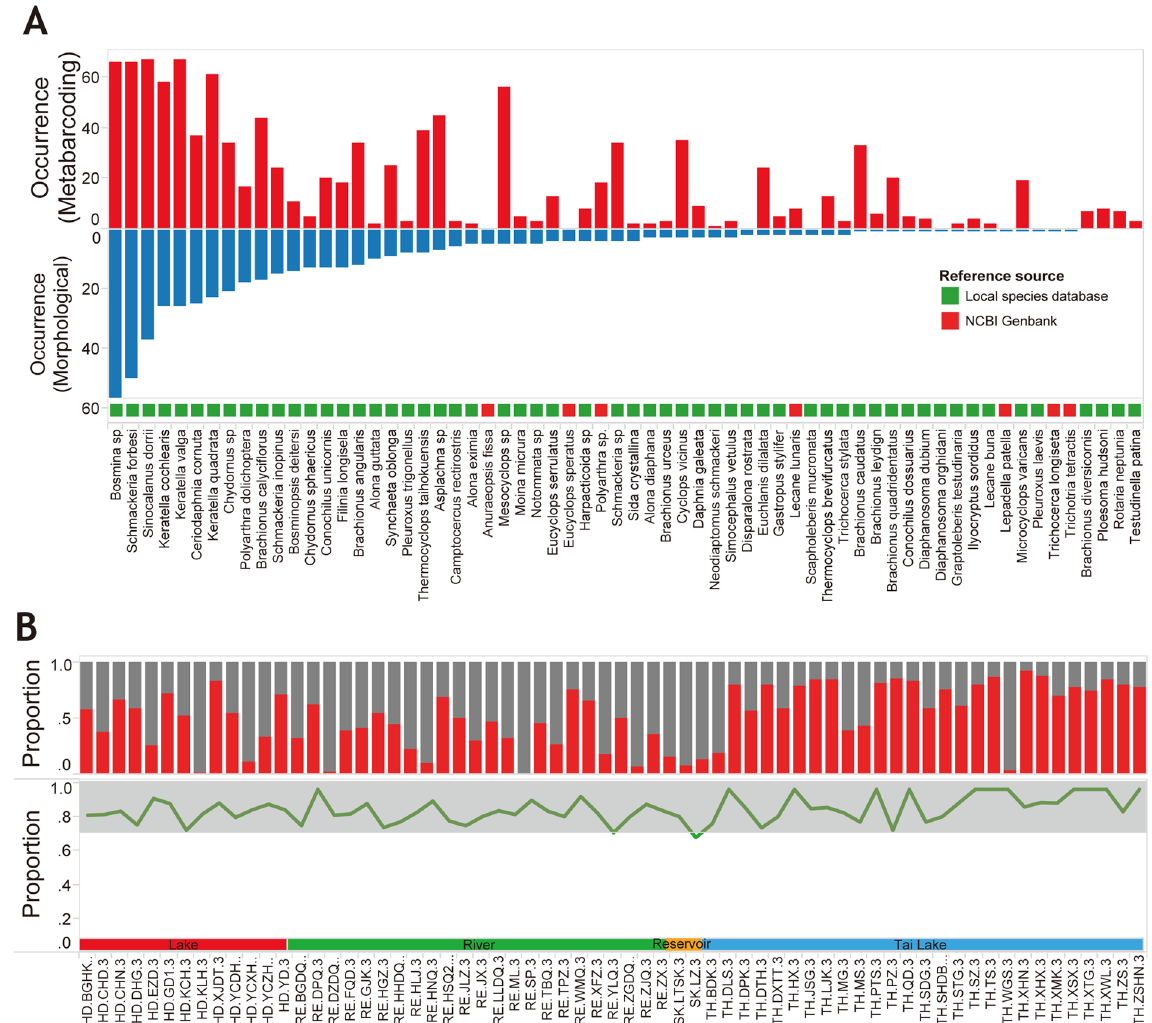
Figure 2. Comparison of metabarcoding data with traditional monitoring data on zooplankton species monitoring. ( A ) Frequency of occurrence of each species by metabarcoding and morphological method. ( B ) The top panel shows the proportion of OTUs in metabarcoding data matched to the morphological identification at each site. Red color indicates the proportion of species detected by both morphological method and metabarcoding. Grey color indicates the proportion of species detected by metabarcoding only. The bottom panel shows the proportion of species detected by metabarcoding at each sample. (e.g. 0.8 means 80% morphological species detected by